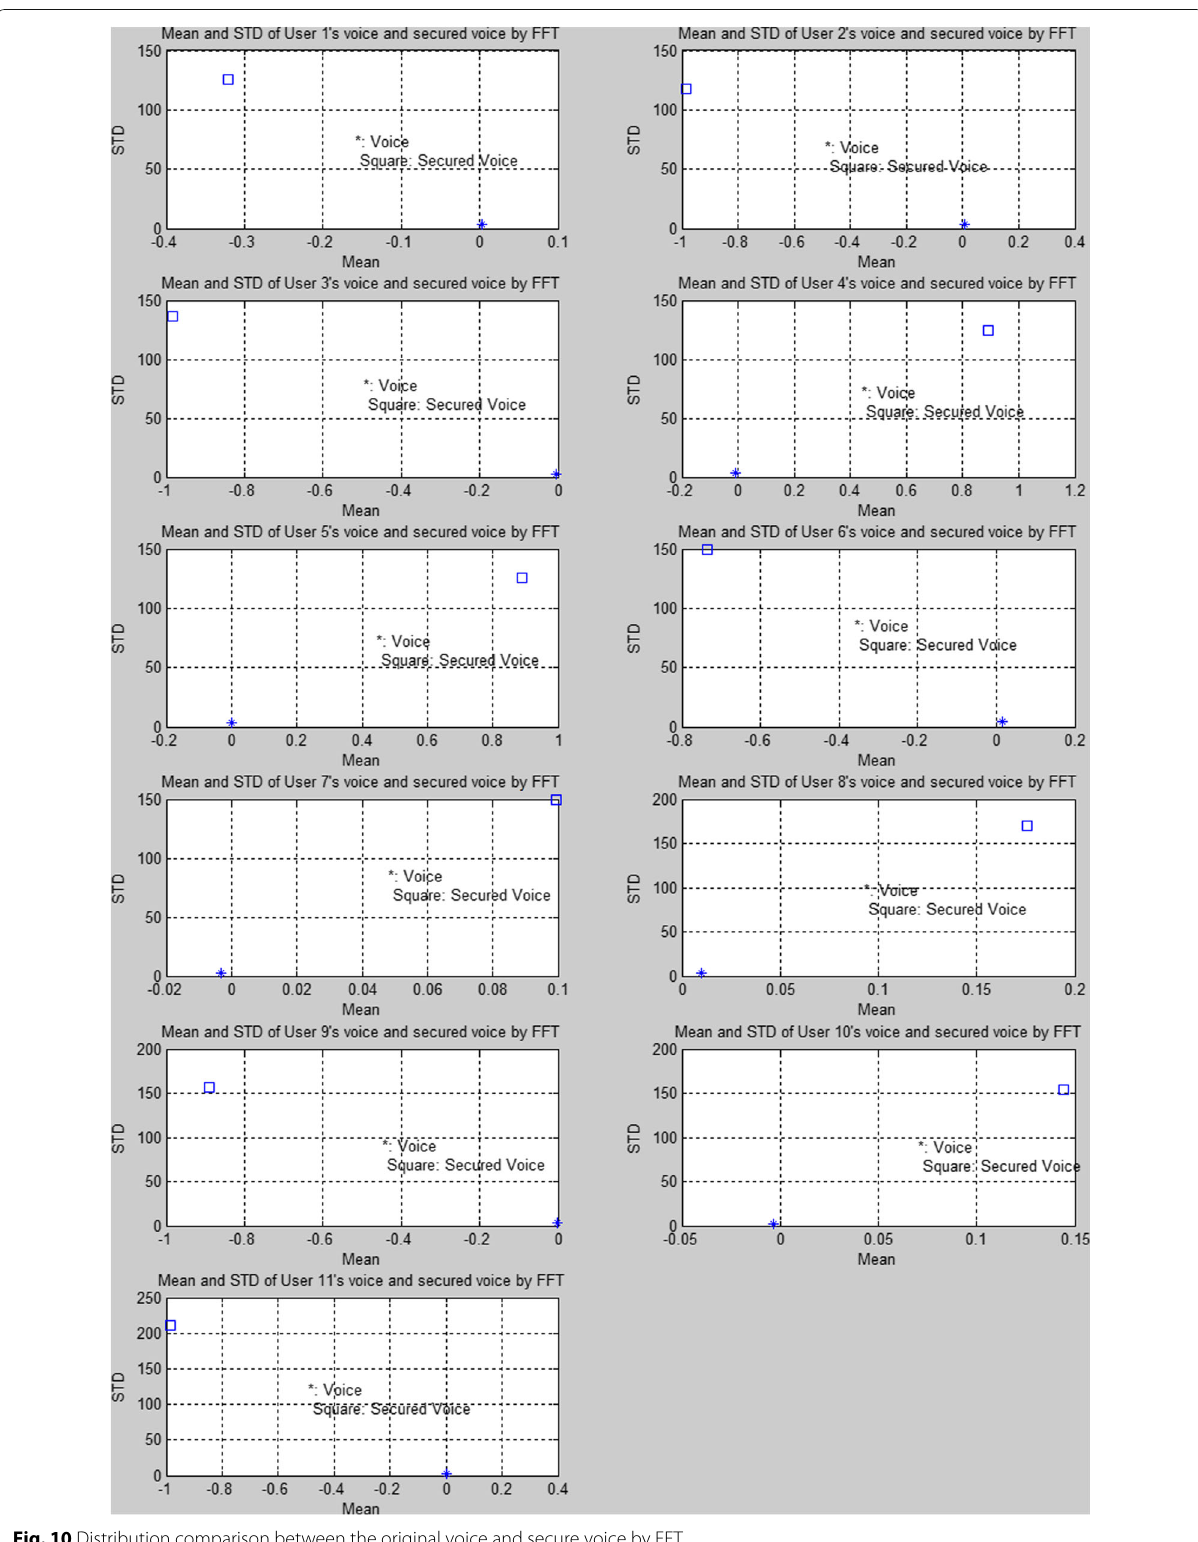
Fig. 10 Distribution comparison between the original voice and secure voice by